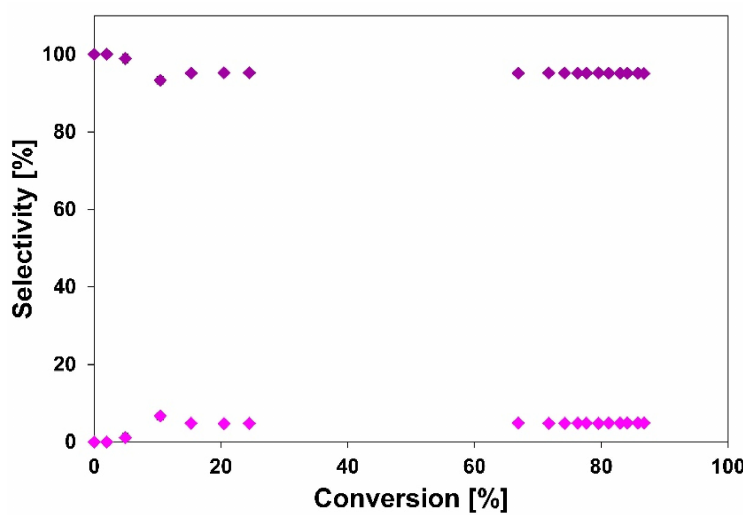
Figure A8. Selectivity profile of the aldol product ( (cid:117) ) and enone product ( (cid:117) ) in the aldol condensation of 4-nitrobenzaldehyde with acetone at 55 ◦ C in a 50/50 vol% mixture of acetone/water with PEGMA- AMP-3 as catalyst. Error bars represent the 95% confidence